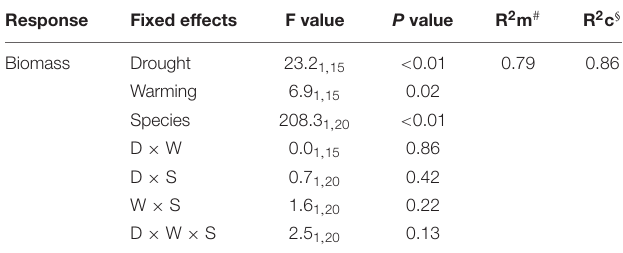
TABLE 3 | Linear mixed effects model output for the combined effects of drought and warming on aboveground productivity of both Medicago sativa and Festuca arundinacea during the 6-month winter/spring